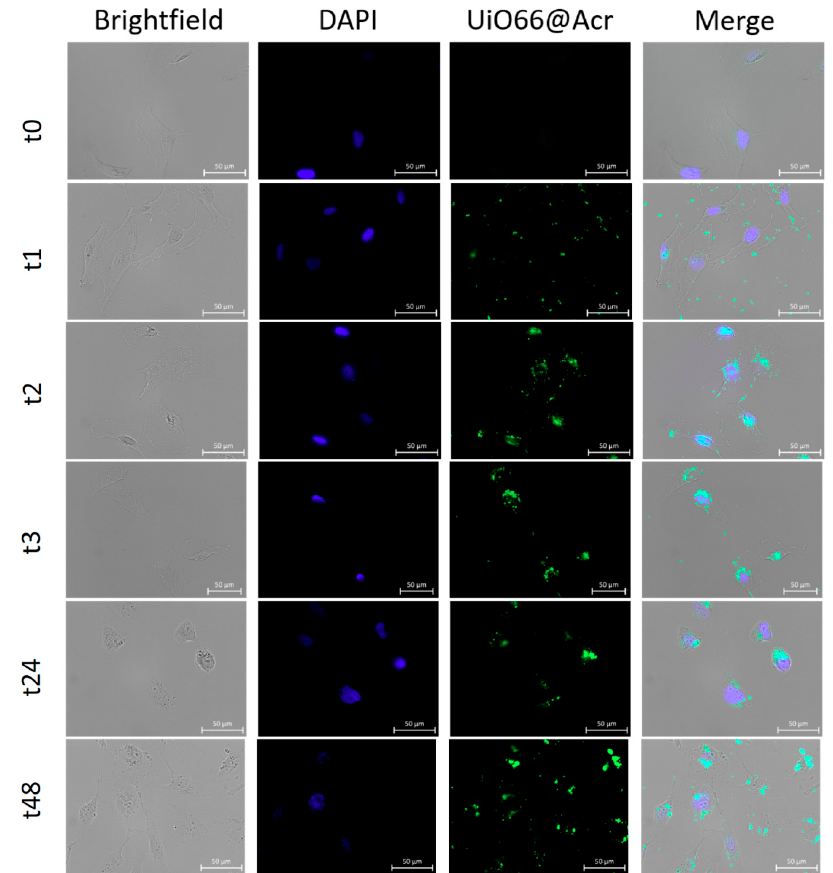
Figure 4. Fluorescence imaging of cells treated with UiO-66_N@Acr at the final concentration of 1 µ g/mL at different times (0, 1, 2, 3, 24, and 48 h) of treatment. Bar 50 µ m